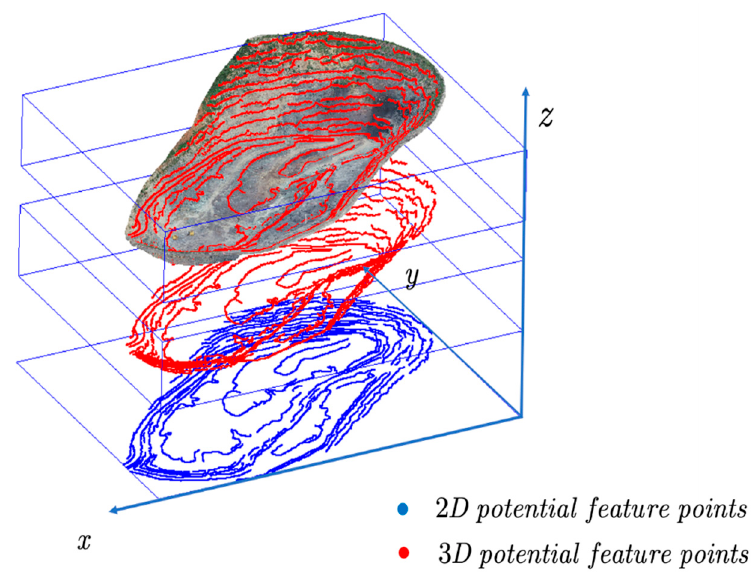
Figure 15. Step-feature-point conversion (the lower blue part is the extracted 2D step-feature points, the middle red part is the 2D step-feature points converted to 3D form, and the upper part is the 3D step-feature points overlaid with the open-pit point cloud).